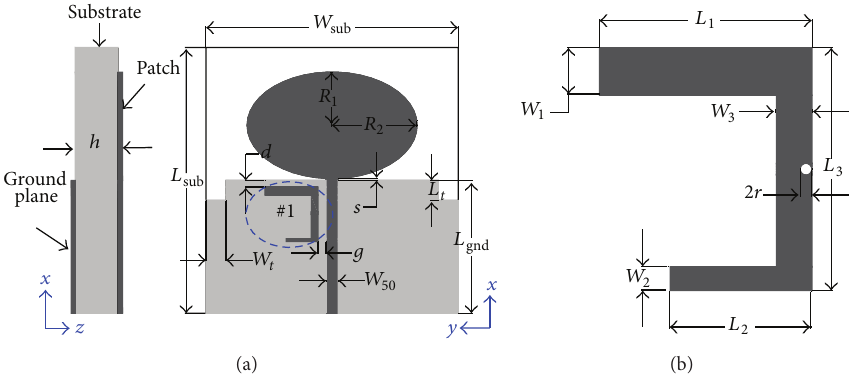
Figure 4: (a) Top view and side view of the proposed antenna. (b) #1 (M-EBG).